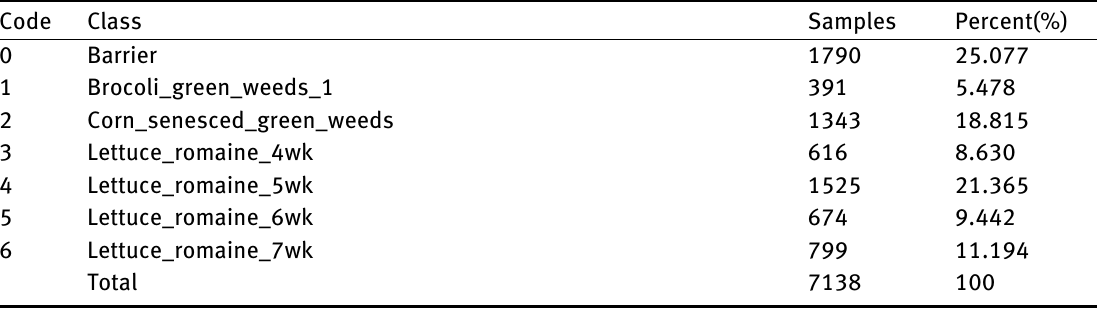
Table 4: Ground Truth Knowledge for Salinas-A with respective samples number